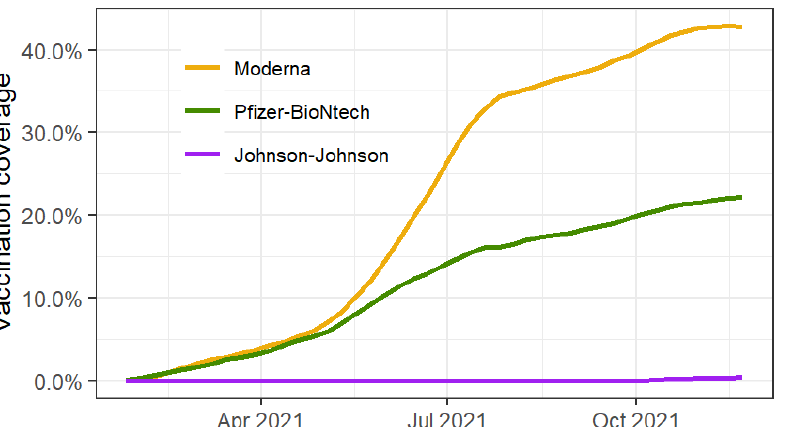
Figure S2. Vaccine coverage in Switzerland over time by type of vaccine (Moderna, Pfizer-BioNtech and